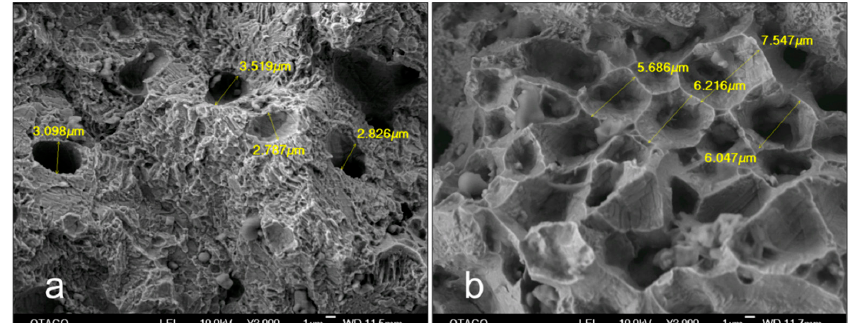
Figure 3. Representative fracture surface SEM ×1000 showing ( a ) fracture surface of LS CoCr dumbbell and ( b ) fracture surface of SM CoCr dumbbell.